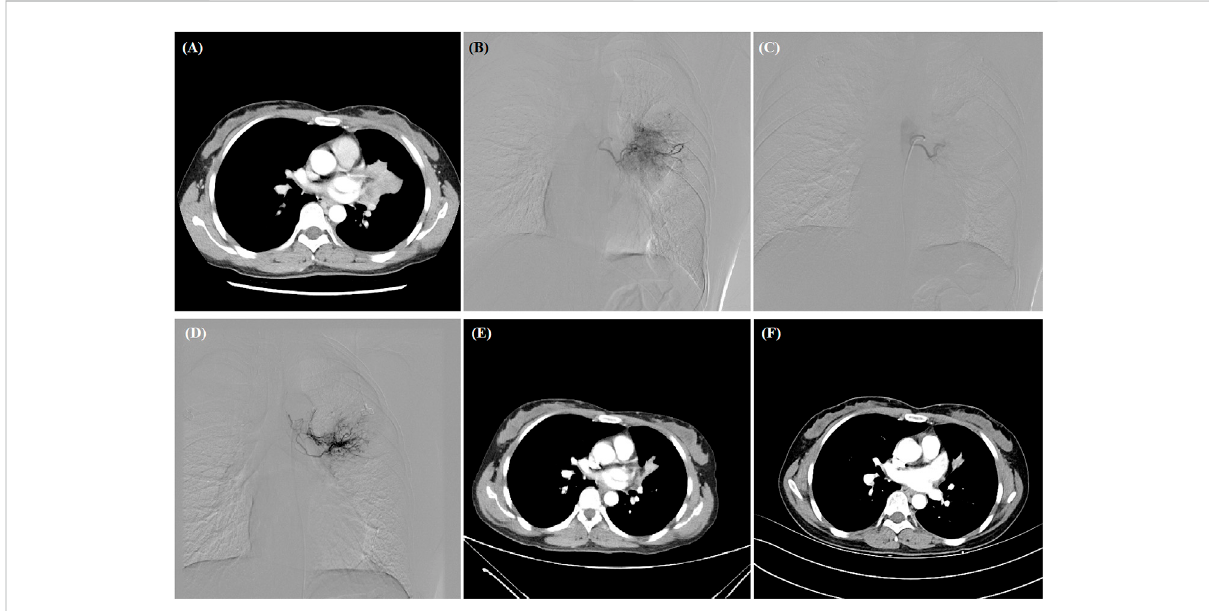
FIGURE 1 A 38-year woman with advanced adenocarcinoma treated by DEB-TACE. (A) CT examination revealed central malignant tumor of left lung. (B,C) The left bronchial artery catheterized and the blood supply artery was embolized by oxaliplatin-loaded CB. (D) The second DEB-TACE was performed after 2 months. (E,F) The leftlung tumor was found to shrink at 1- and 3-monthfollow-up, and thiswoman isstill alive after 36.3